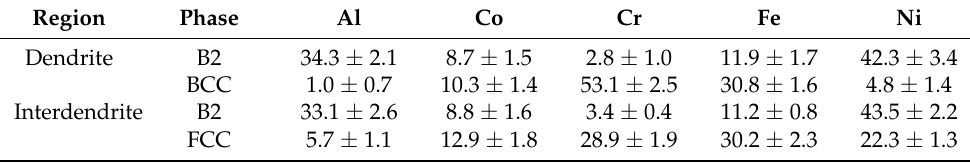
Table 5. Chemical composition (at.%) of the interior phases marked in Figures 6 and 7.